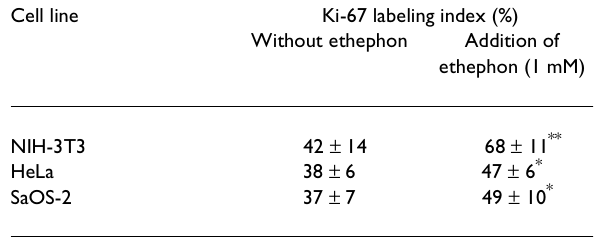
Table 1: Effect of ethylene on proliferative activity of mammalian cells. The proliferative activity of the cells is expressed as Ki-67 la- beling index. Results are means ± S.D. of 8 independent experiments.